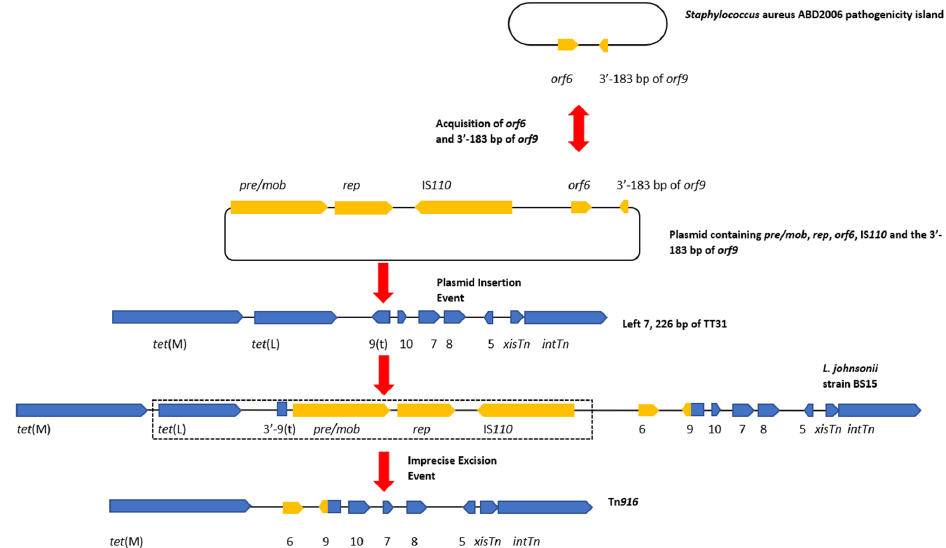
Figure 4. A diagram of the hypothetical events that led to the creation of Tn 916 . This hypothetical event assumes that the left 7226 bp of TT31 are a part of a larger Tn 916 -like element. Gene diagrams are not to scale. A plasmid containing pre / mob and rep genes and an IS 110 transposase obtains orf6 and the 3 (cid:48) —end of orf9 (yellow) from the Staphylococcus aureus ABD2006 pathogenicity island. A double-headed arrow between the Staphylococcus aureus ABD2006 pathogenicity island and the plasmid indicates that orf6 and the 3 (cid:48) -183 bp of orf9 may have transferred in either direction. Both scenarios demonstrate the mobility of this region of DNA. Insertion of this plasmid then occurs within orf9t of the TT31 Tn 916 -like element which creates the L. johnsonii strain BS15 encoded ‘intermediate’ Tn 916 -like element. This plasmid insertion disrupts the orf9t reading frame resulting in the creation of the larger fusion orf9 (yellow and blue) although the 3 (cid:48) —end of orf9t is still present in L. johnsonii strain BS15. An imprecise excision event then occurs which results in the loss of the pre / mob , rep , IS 110 transposase and tet (L) genes as well as the 3 (cid:48) —end of orf9t (indicated by a dotted box), creating Tn 916